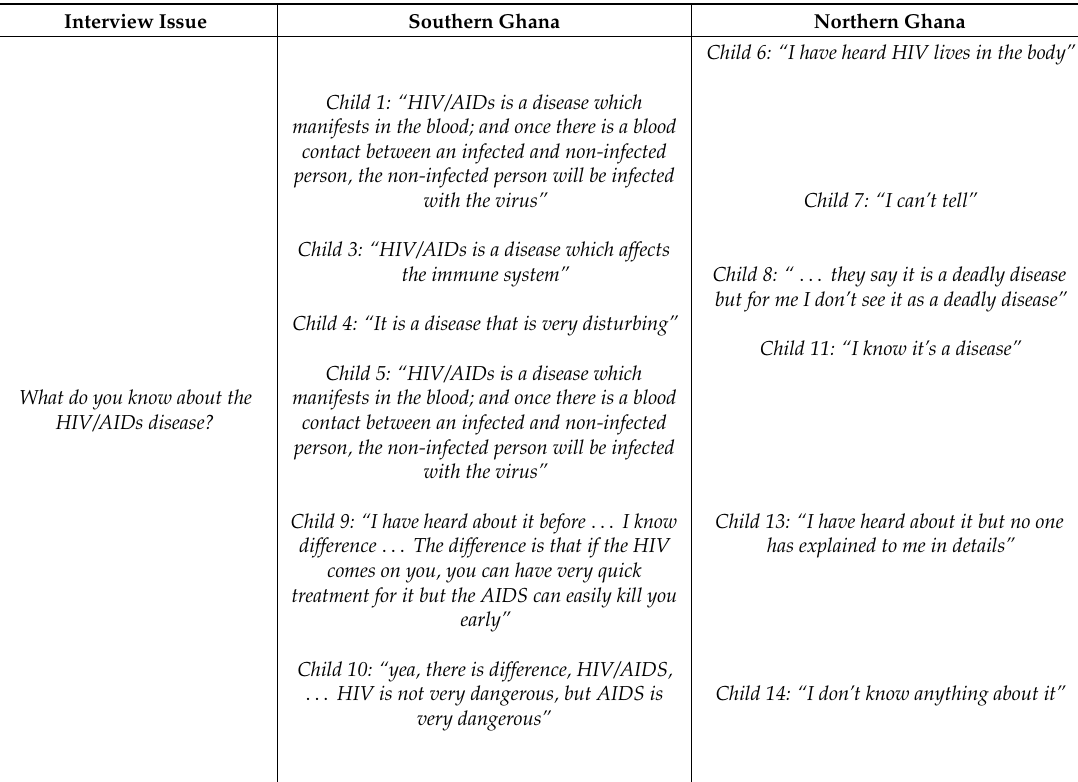
Table 3. Comparing HIV and AIDS knowledge levels of study